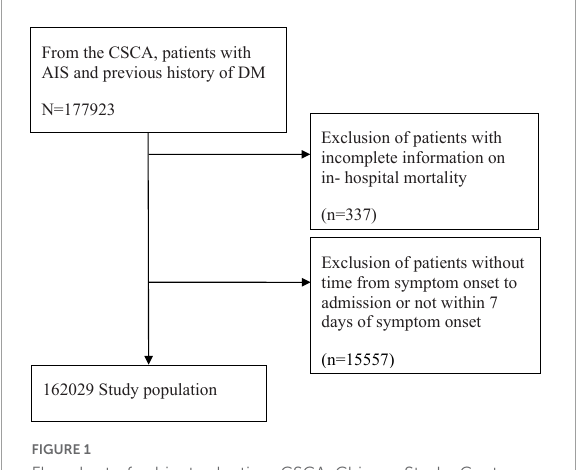
FIGURE1 Flowchart of subject selection. CSCA, Chinese Stroke Center Alliance; AIS, acute ischemic stroke; DM, diabetes